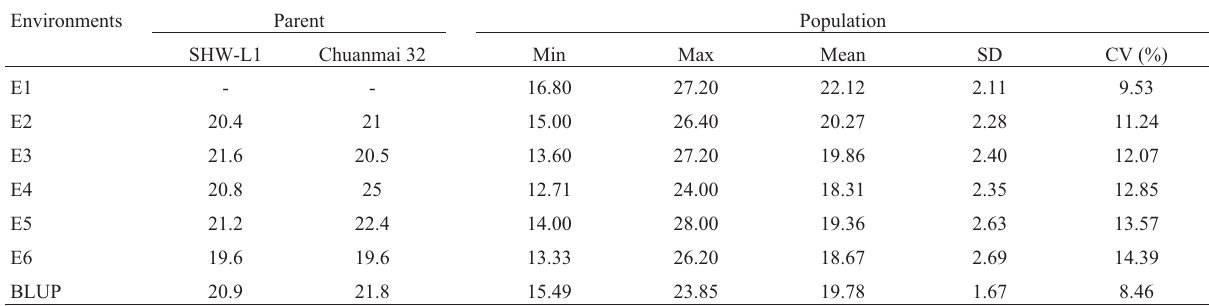
Table 1 - The mean phenotypic performance for TSS of the recombinant inbred lines (RILs) and their parents in six environments. Environments Parent